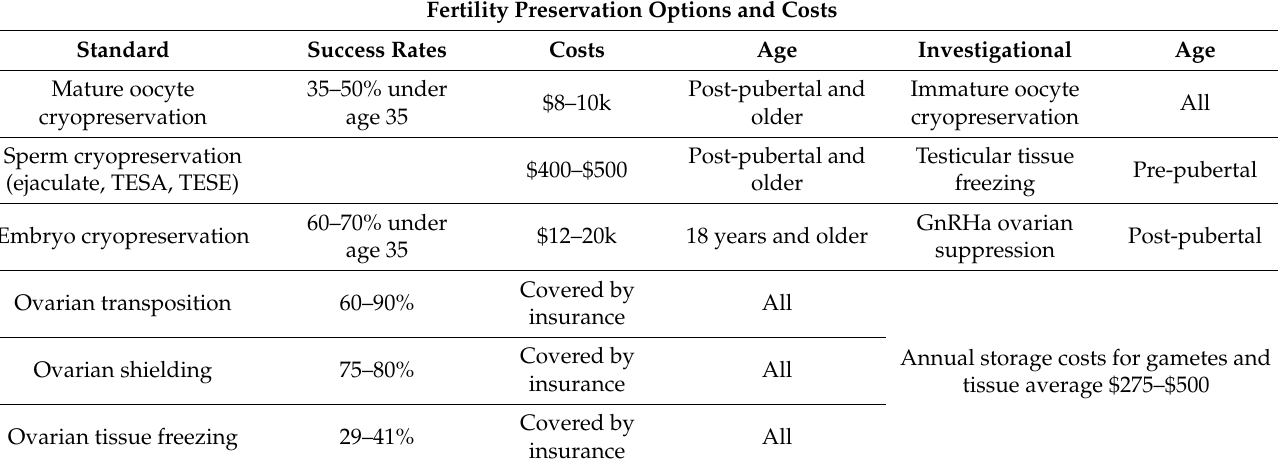
Table 3. Fertility Preservation Options and